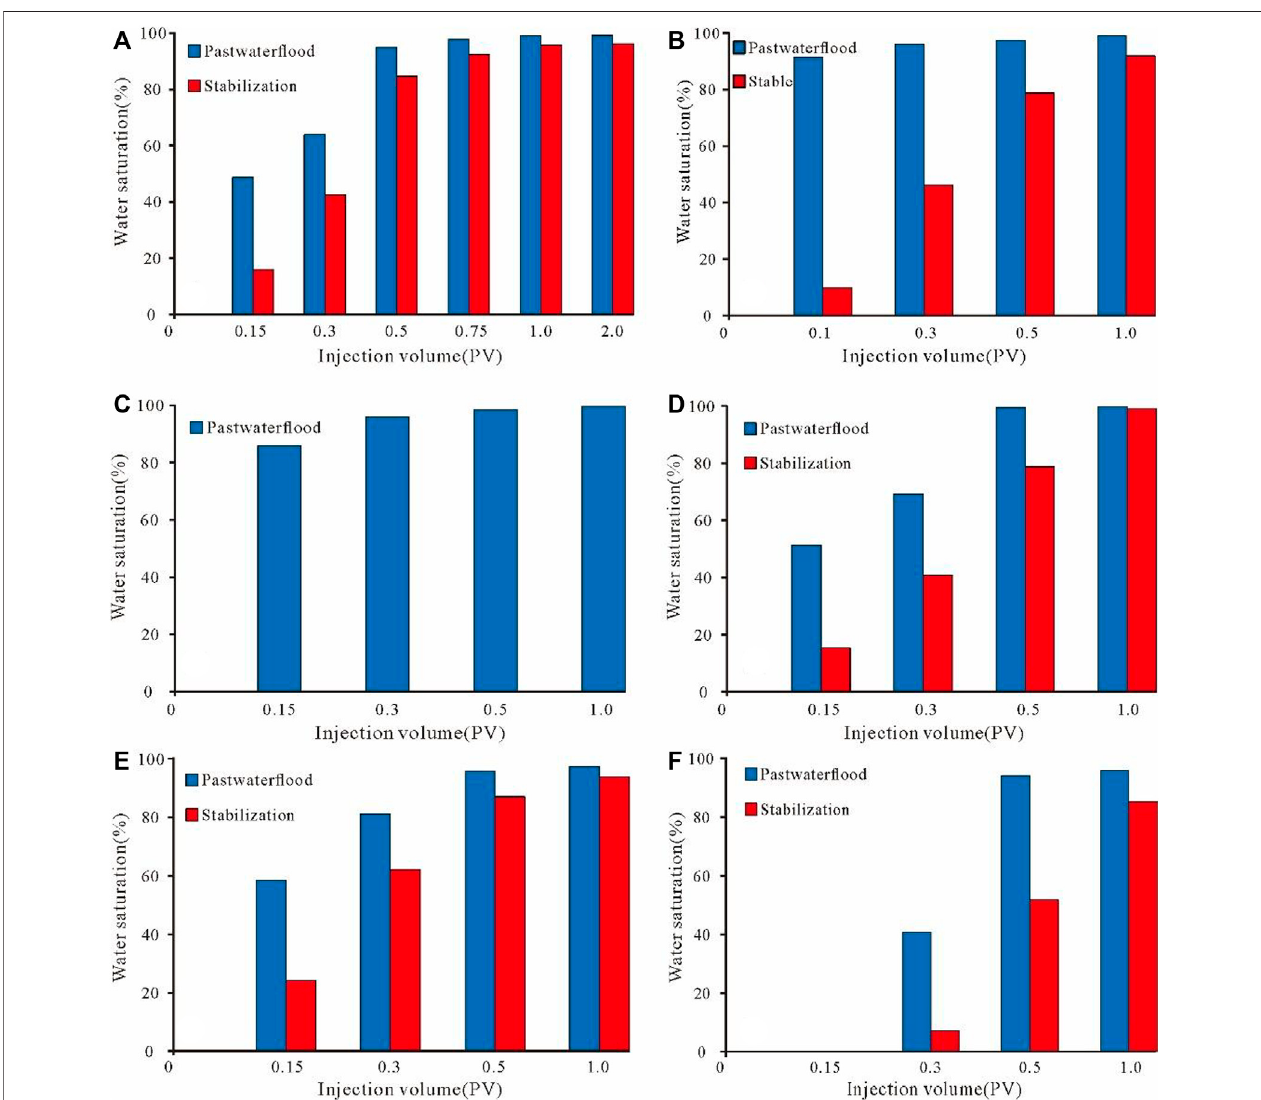
FIGURE 11 | Water injection volume and water saturation for different samples. Note: (A) Sample #64 (HLF), (B) Sample #19 (HLF), (C) Sample #51 (HLF), (D) Sample #21 (HCF), (E) Sample #9 (HCF), and (F) Sample #3 (TF).